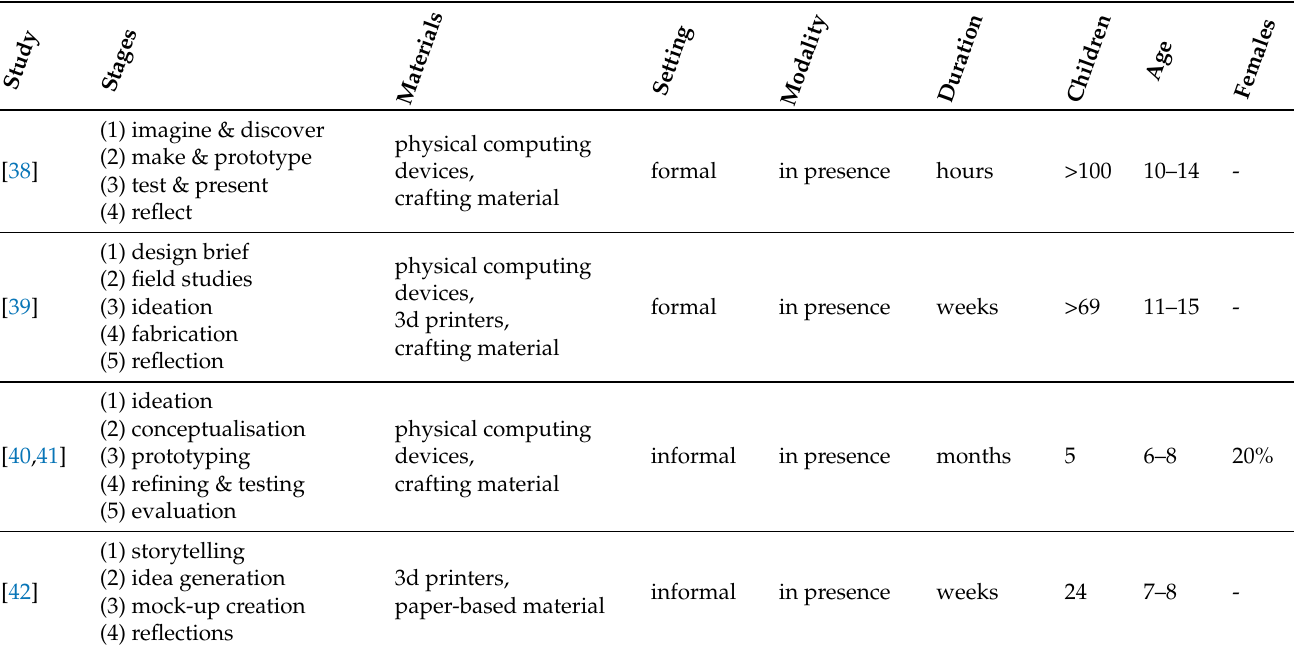
Table 2. Summary of smart object design workshops with